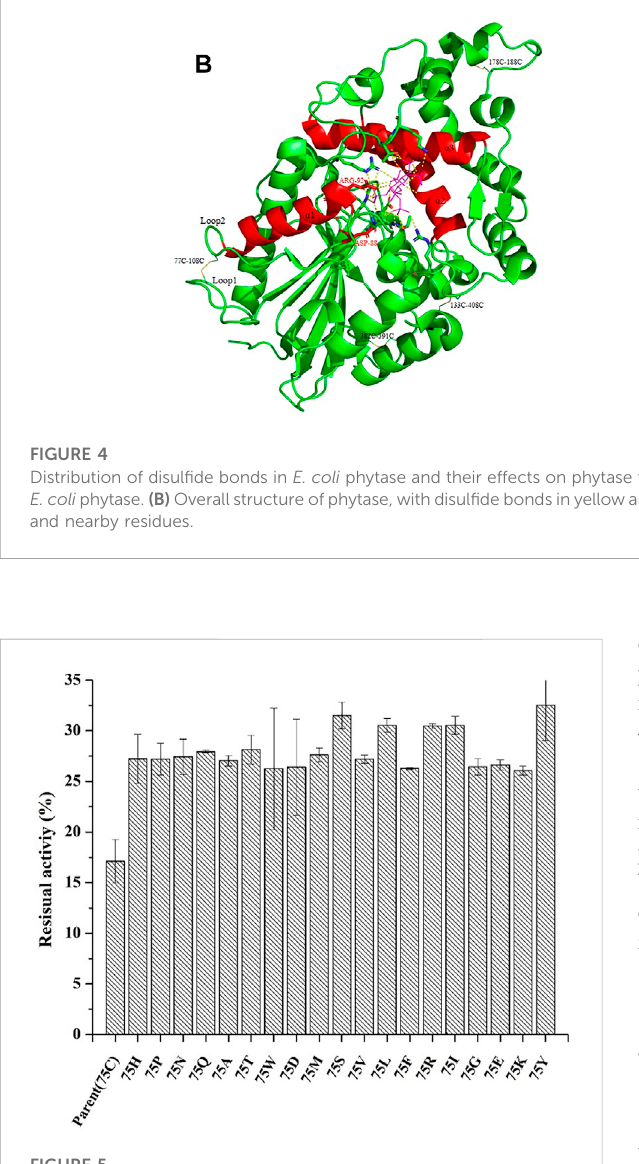
Tool (Figure 6). The binding energy between the mutant F8 docking and structures phytate was − 4.24 Kcal/mol, which is much lower than that of the parent ( − 2.07 Kcal/mol). This indicated that the mutant F8 is more likely to bind to phytate after substitution of C at the 75 site. Analyzing the binding position